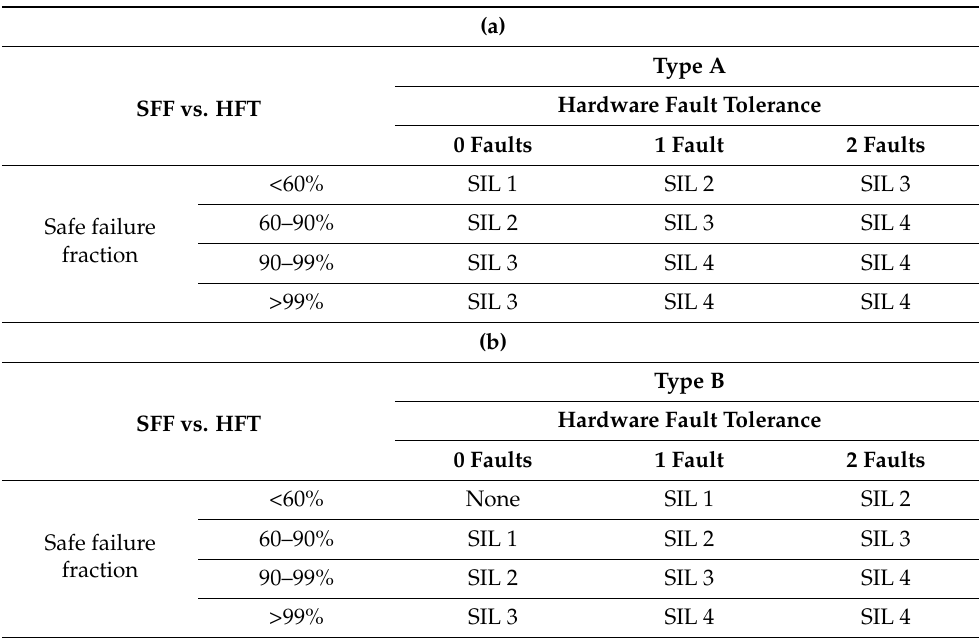
Table 2. Route 1H procedure according to SIS design in compliance with IEC 61508:2010 [44]. ( a ) Reference values for a type A element; ( b ) reference values for a type B